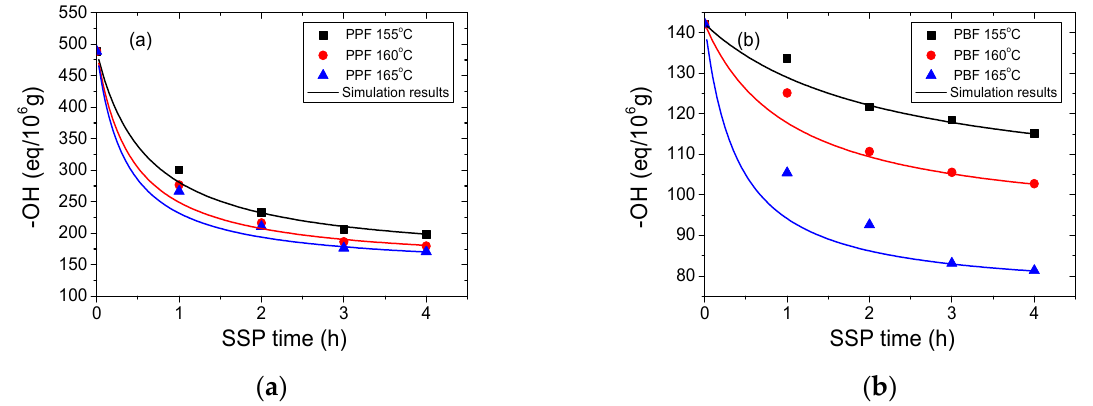
Figure 5. Evolution of hydroxyl (–OH) end-groups concentration with time during SSP of ( a ) PPF and ( b ) PBF polyesters at different temperatures. Simulation results are represented by the continuous lines.